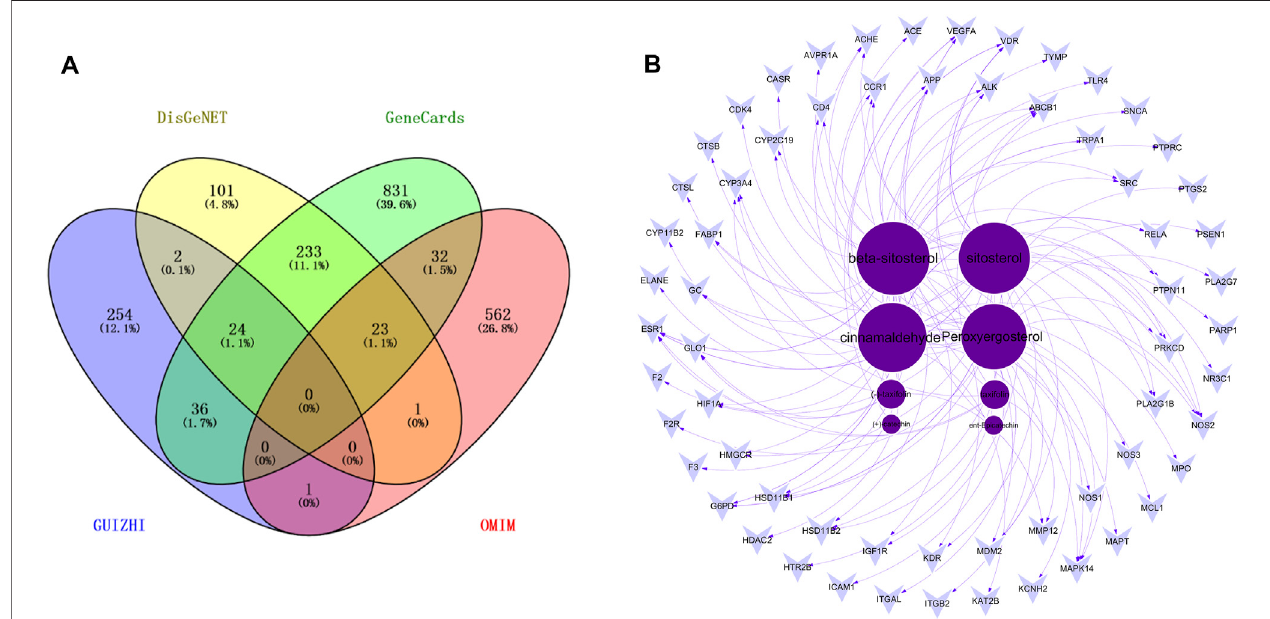
FIGURE 2 | The Venny plot of 63 intersecting targets (A) and the active component-target network (B) .